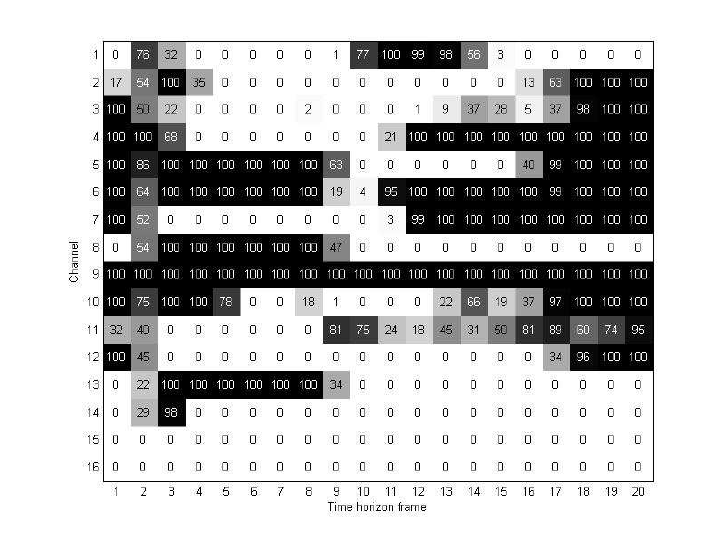
Figure 7. Two-dimensional discriminant information